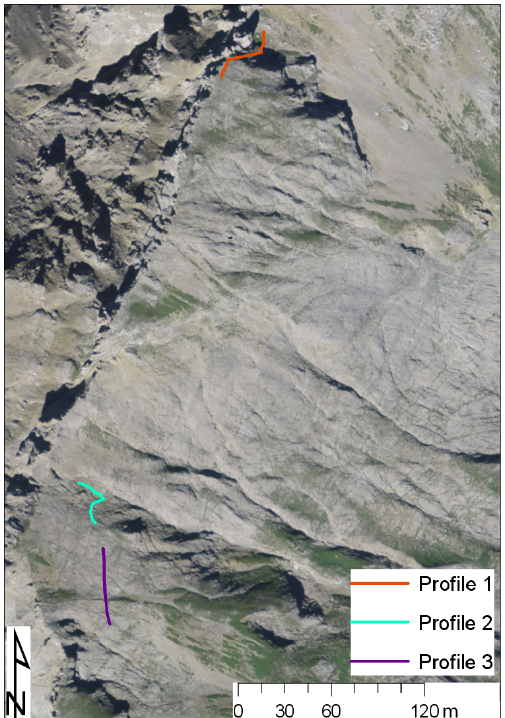
Figure 13. Locations of snow depth profiles in the CB1 basin (pro- files 2 and 3) and at the border between CB1 and CB2 (profile 1).